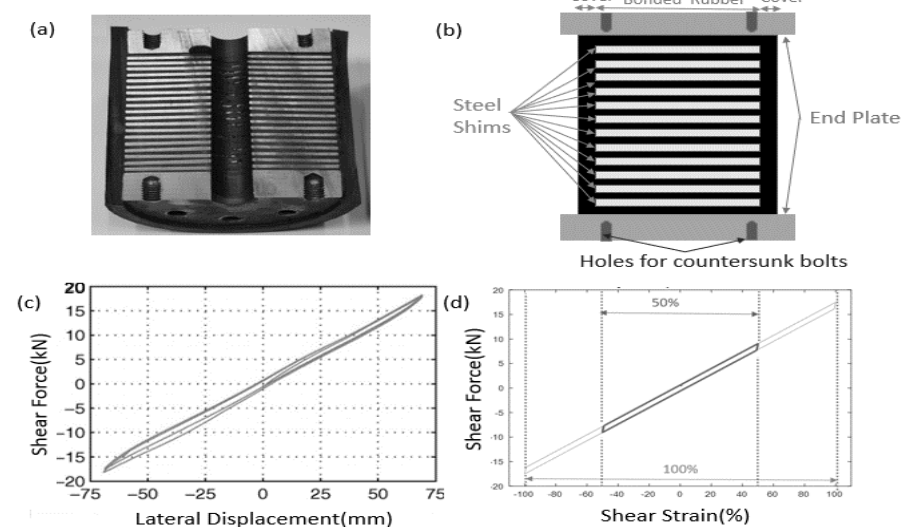
Figure 4. Idealized bilinear force-displacement relationship of an isolation system. Figure 4. ( a ) Internal construction of a generic LDRB ( b ) A schematic view of LDRB ( c ) Example test data of LDRB ( d ) Cyclic response of the tested bearing obtained from an analytical model for 50% and 100% shear